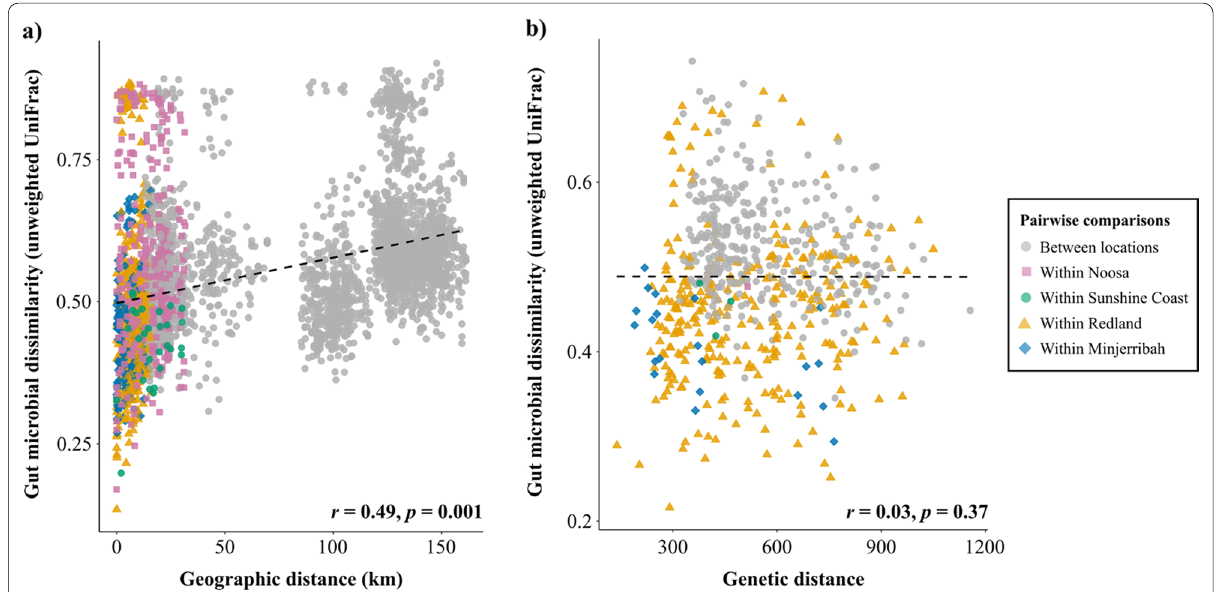
Fig. 6 Pairwise dissimilarity between microbiome beta diversity (unweighted UniFrac) and a geographic distance and b genetic distance. Each point represents the pairwise distance between two individuals and are coloured depending on whether pairs came from the same location (coloured points) or different locations (grey points). The grey dashed line shows the overall trend; Mantel tests were run to determine correlation, where r is the correlation value and P value is the probability associated with